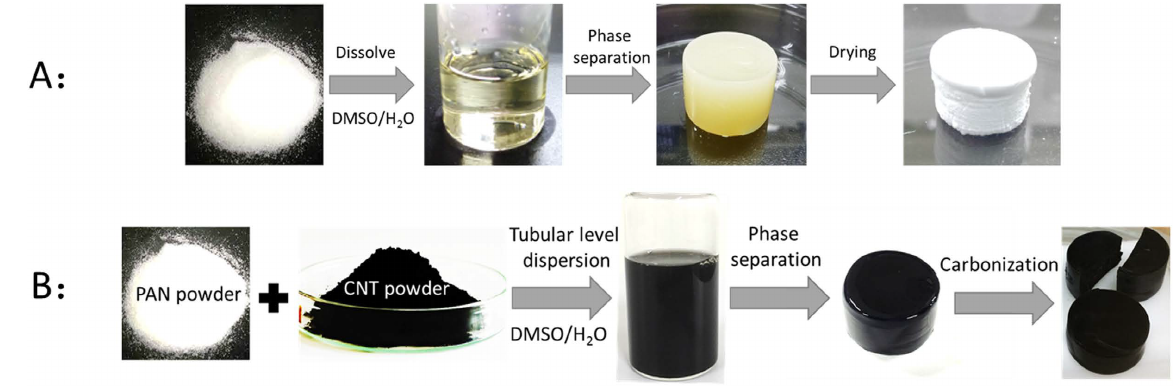
Figure 9: Preparation of typical three-dimensional (3D) hierarchical PAN ( A ) and PANCNT ( B ) monoliths